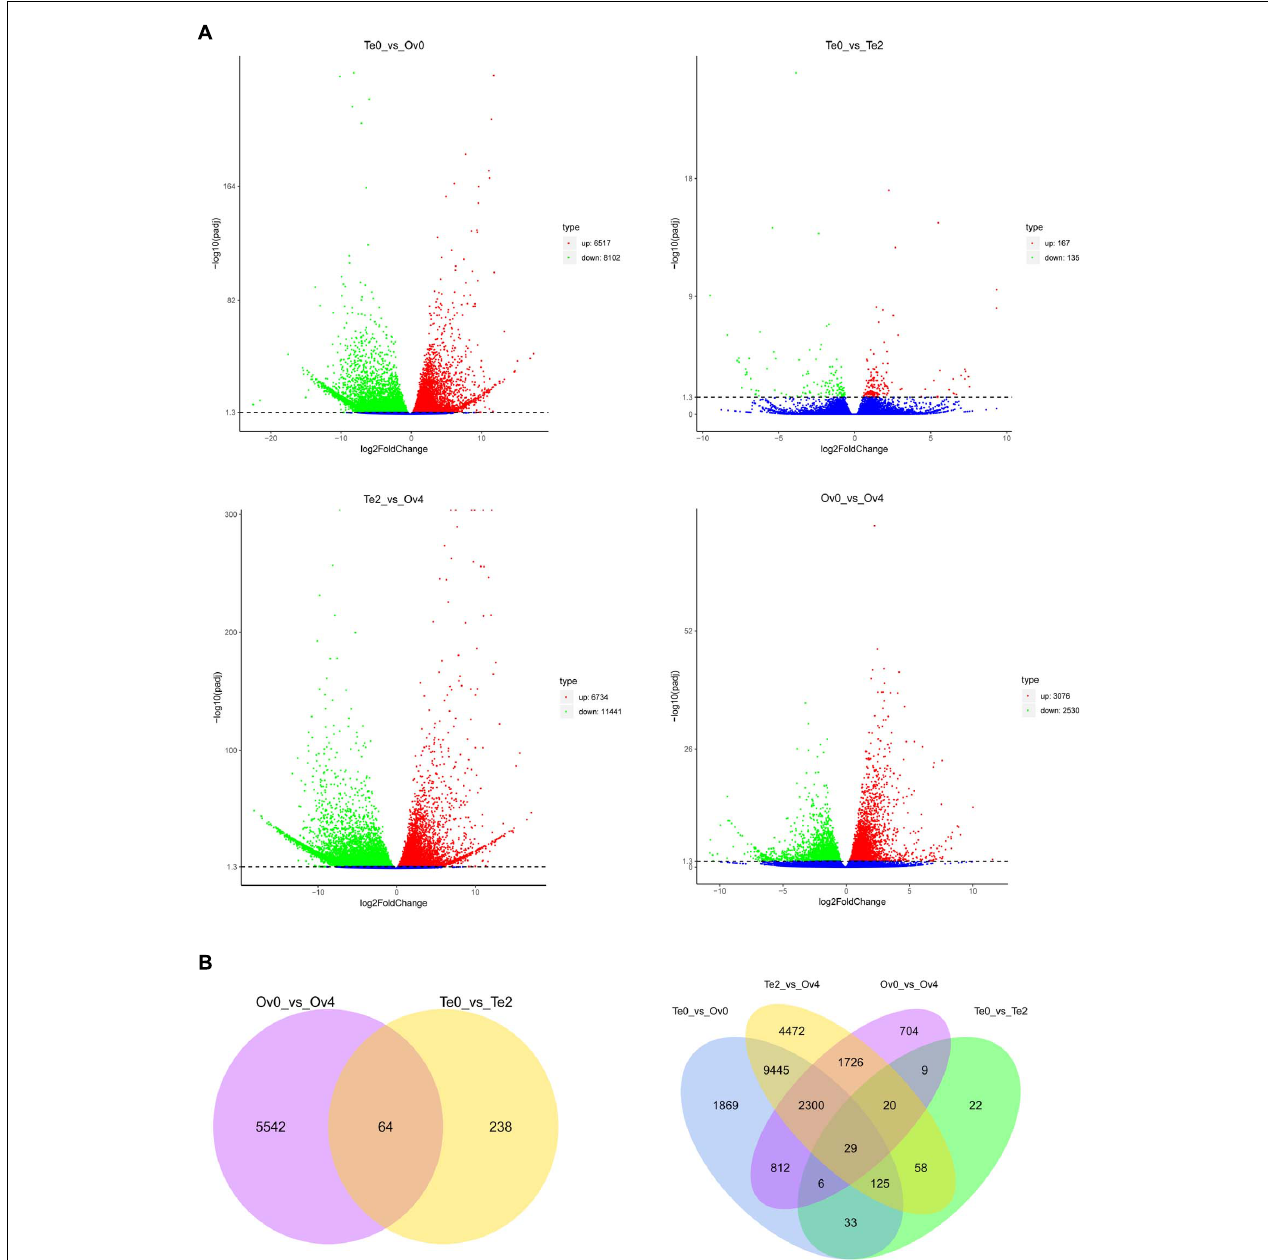
FIGURE 9 | Comparative analyses of differentially expressed genes (DEGs) among groups. Volcano plot (A) and Venn diagram (B) of